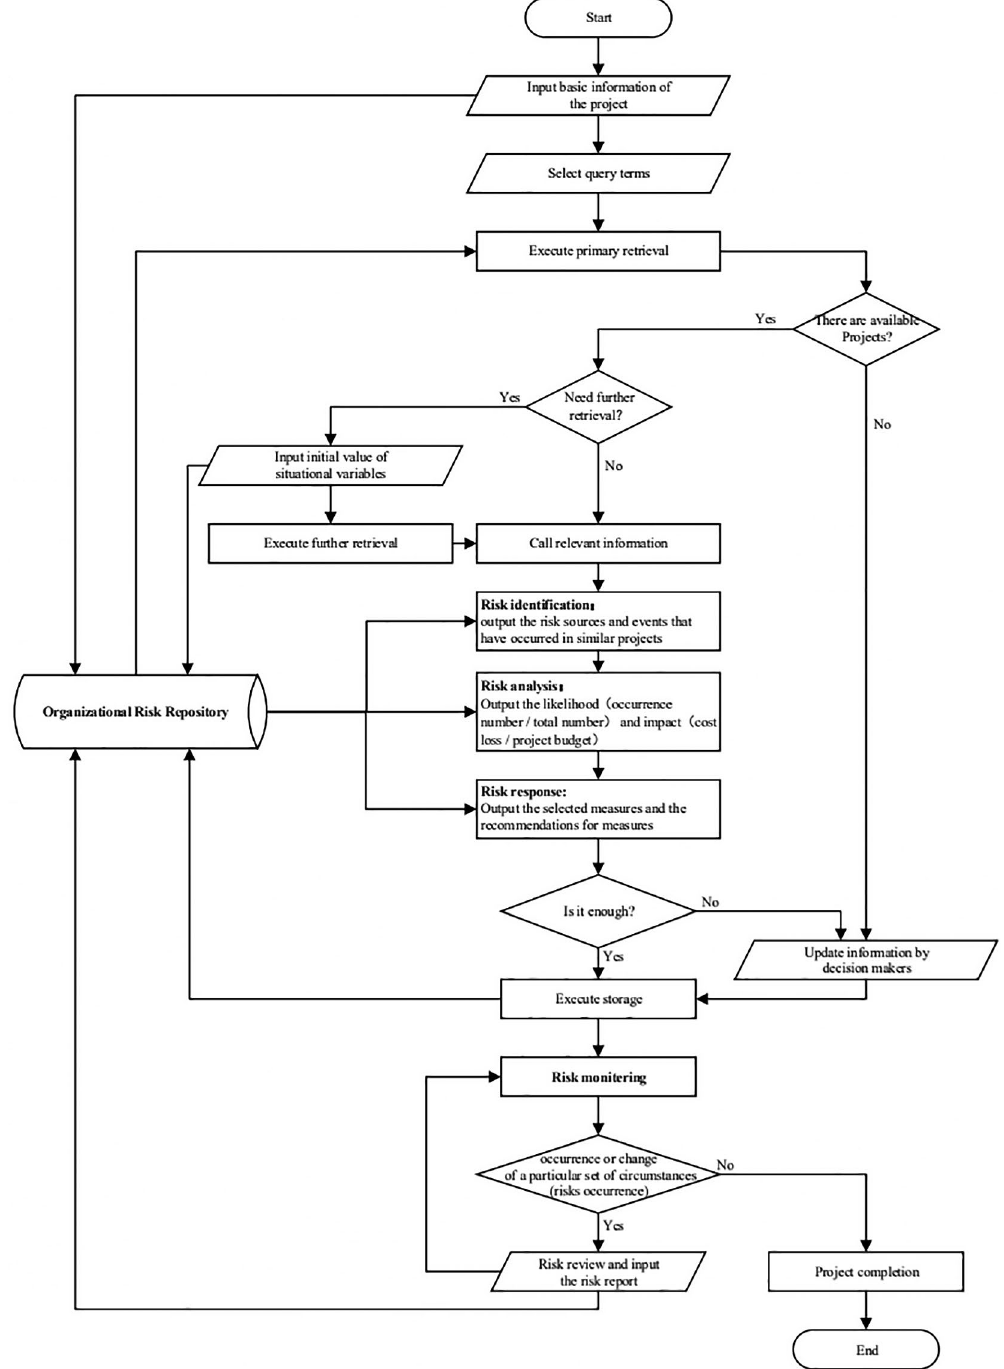
Figure 6. Risk management process coupled with the organizational risk